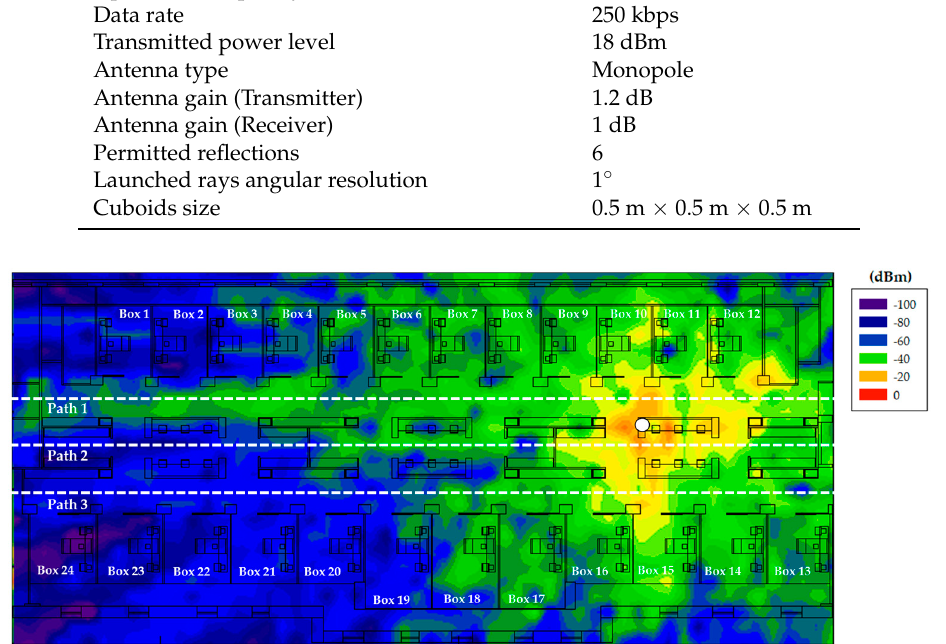
Figure 11. RF power distribution at height 1.5 m obtained by the 3D Ray Launching software. Transmitter is represented by a white dot.